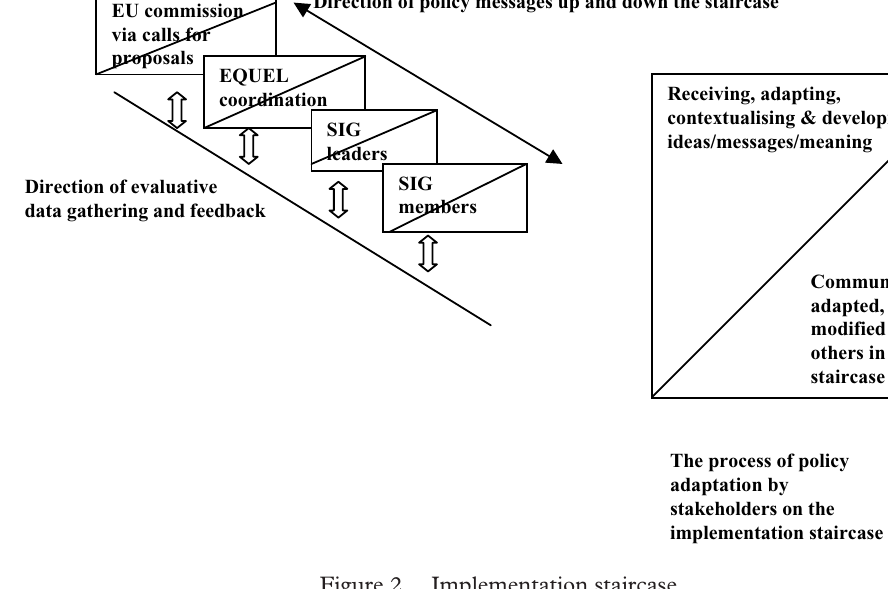
Figure 2. Implementation